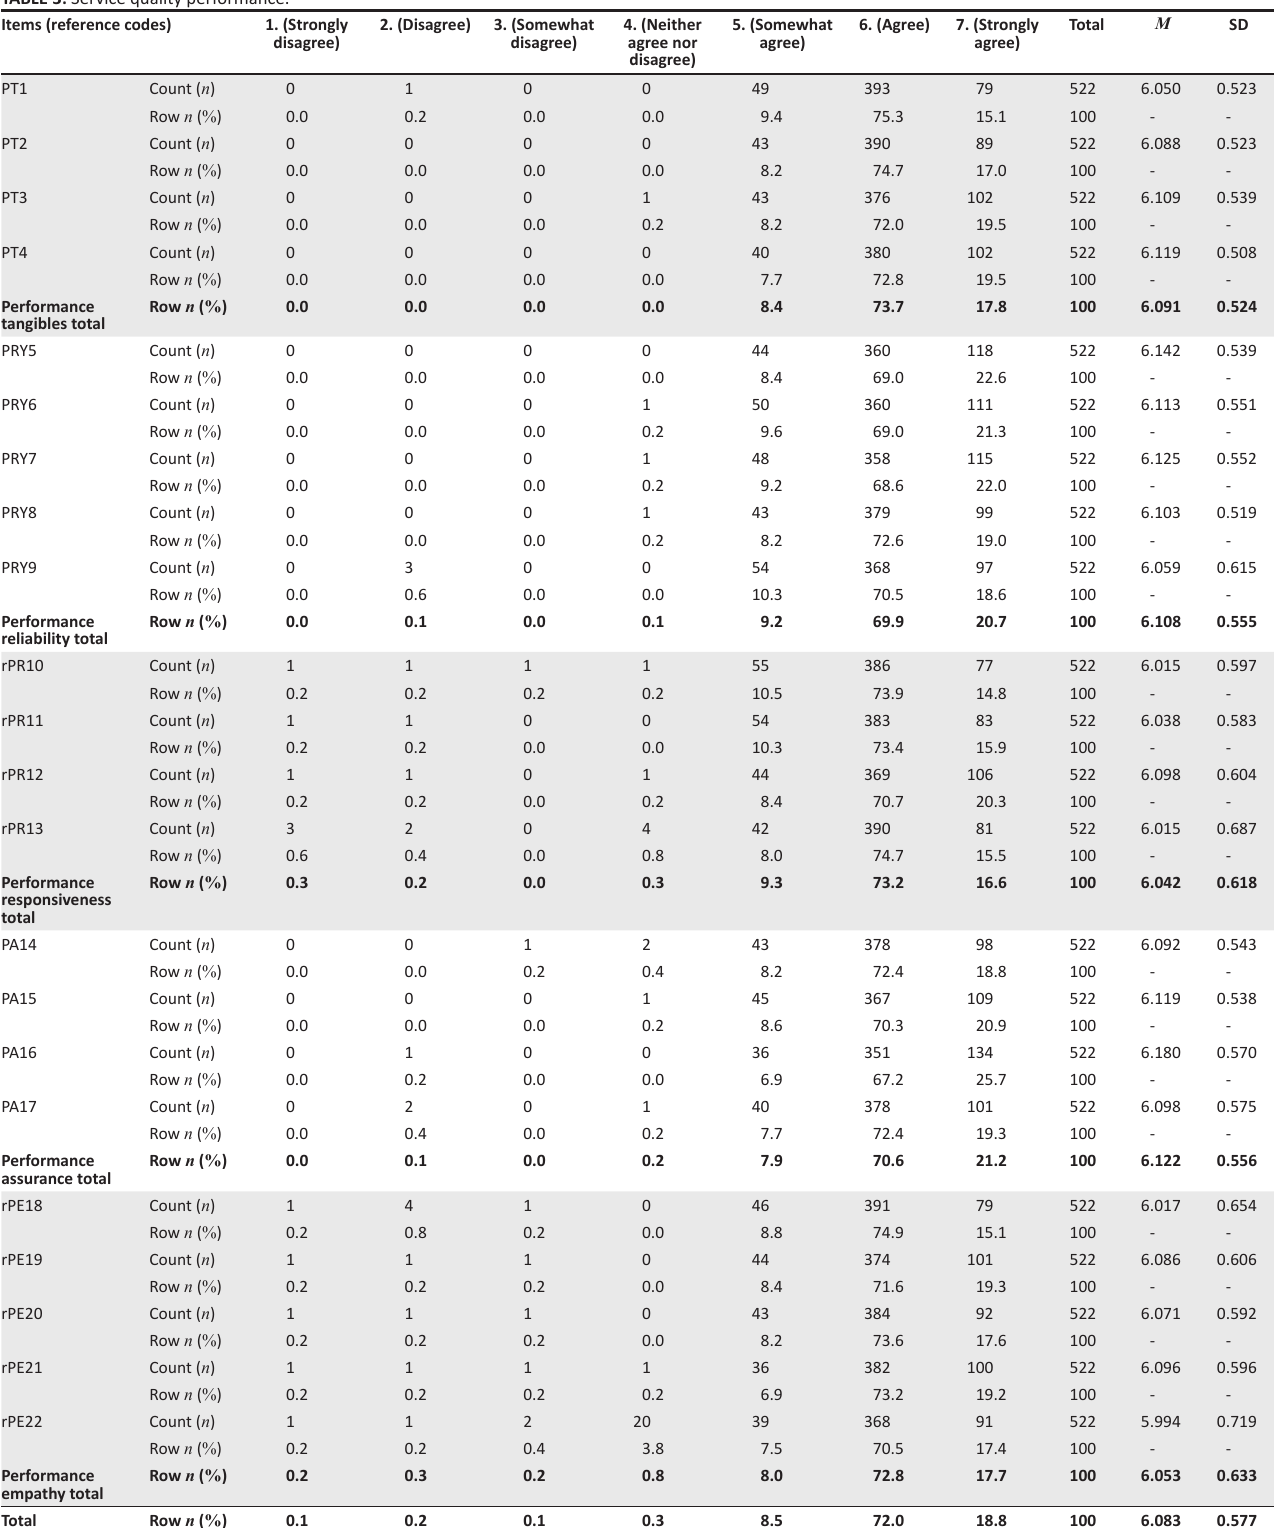
TABLE 3: Service quality performance. Items (reference